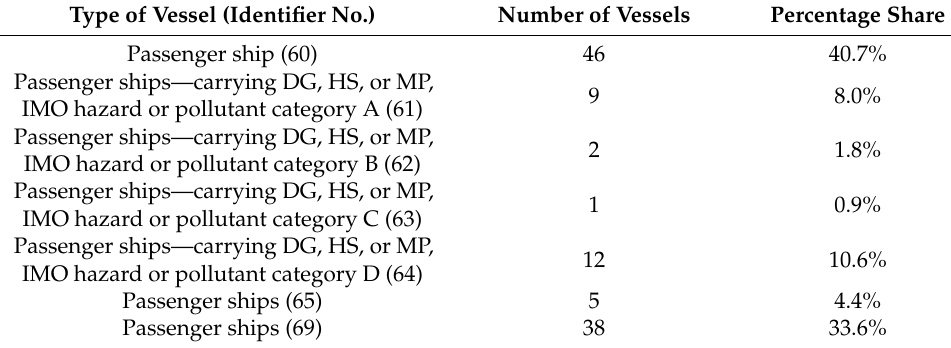
Table 4. List of unique passenger ships staying in the waters in 2017, broken down by type. Type of Vessel (Identifier